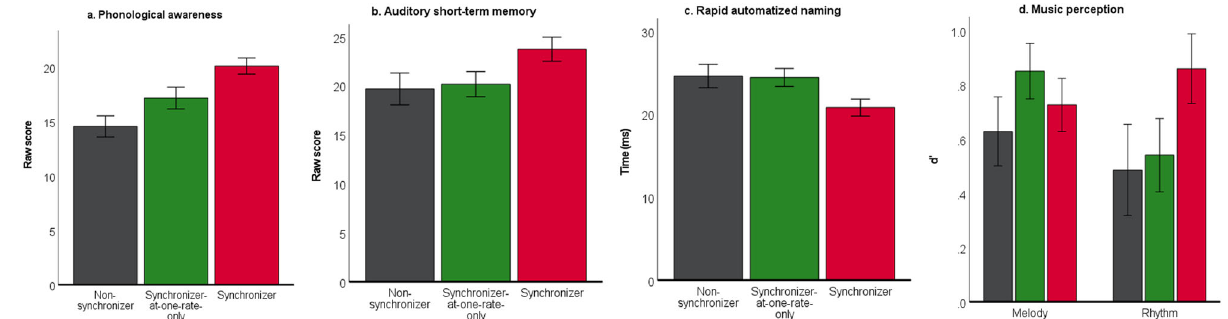
Fig. 6 Synchronizers (red), Synchronizers only at one rate (green), and Non-synchronizers (dark gray) performance across preliteracy and music discrimination tasks. ( a ) Phonological awareness; ( b ) Auditory short-term memory; ( c ) Rapid automatized naming; ( d ) Music